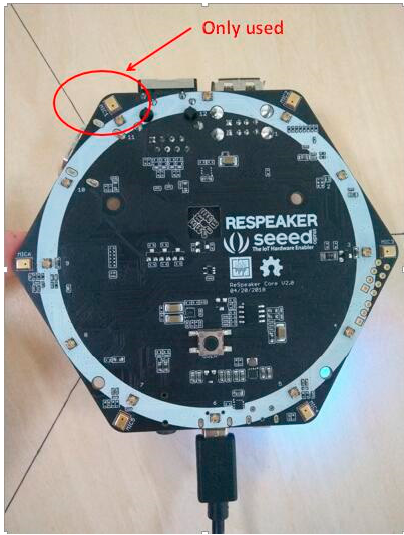
Figure 13. Seeed ReSpeaker Core v2.0 consisting of six microphones. The microphone circled in red is the one we used in our experiments.